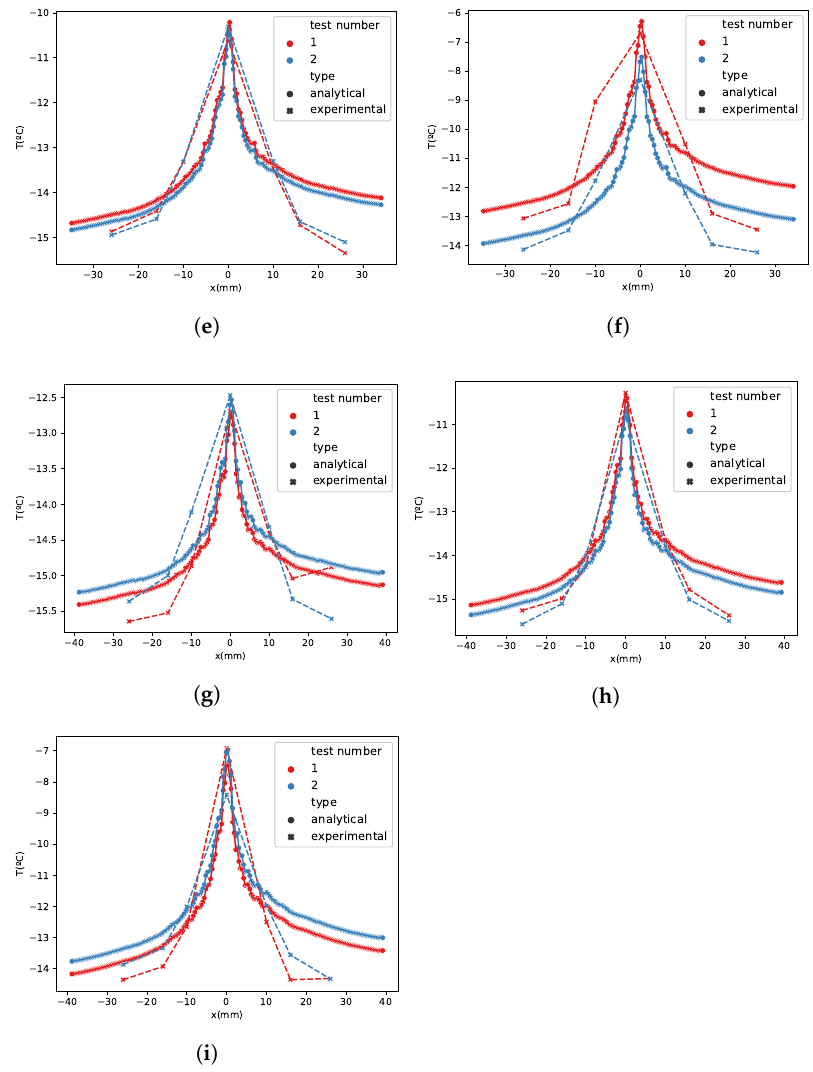
Figure 7. Rime test matrix. Angle of attack: 0 ◦ . Test cases: ( a ) 10 ( b ) 13 ( c ) 16 ( d ) 11 ( e ) 14 ( f ) 17 ( g ) 12